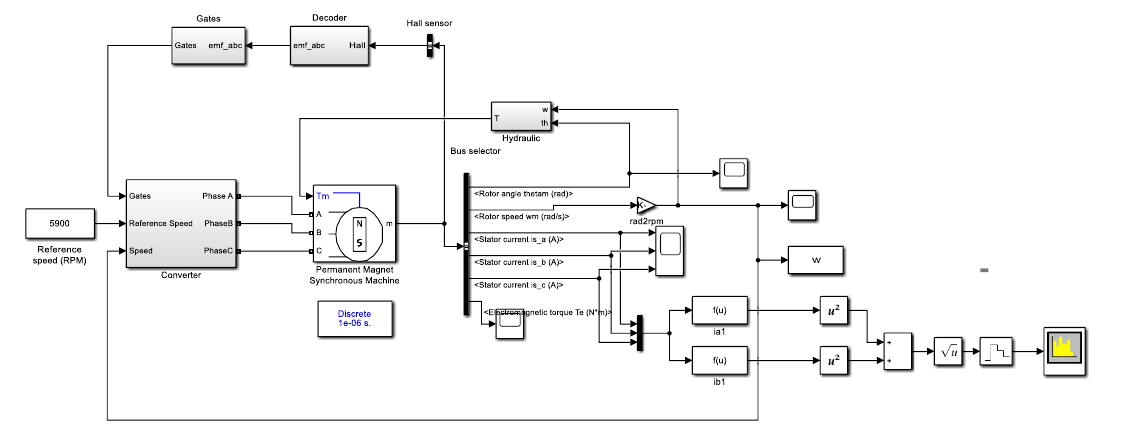
Figure 2. Simulation model of electromechanical system and electronic commutator